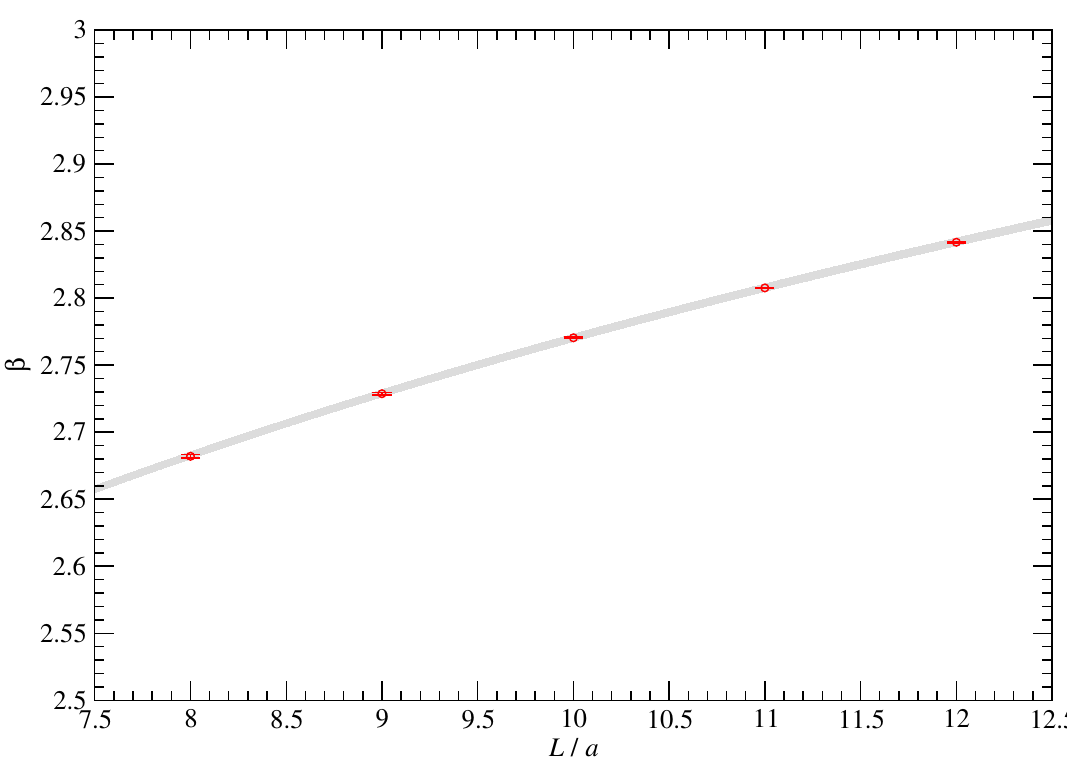
corresponding to g 2 = 4 : 85 0